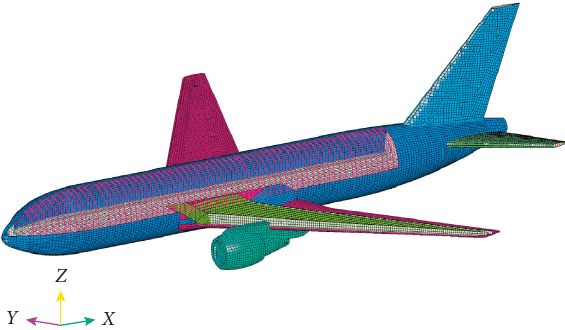
Figure 1: Illustration of the FE model of Boeing